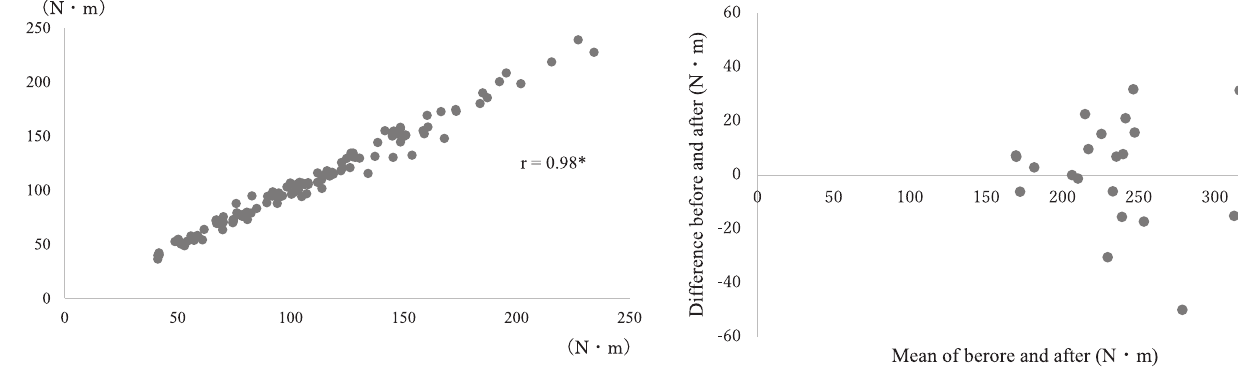
Figure 10 Correlation coefficient for maximum torque before and after modification of the leg extension machine.